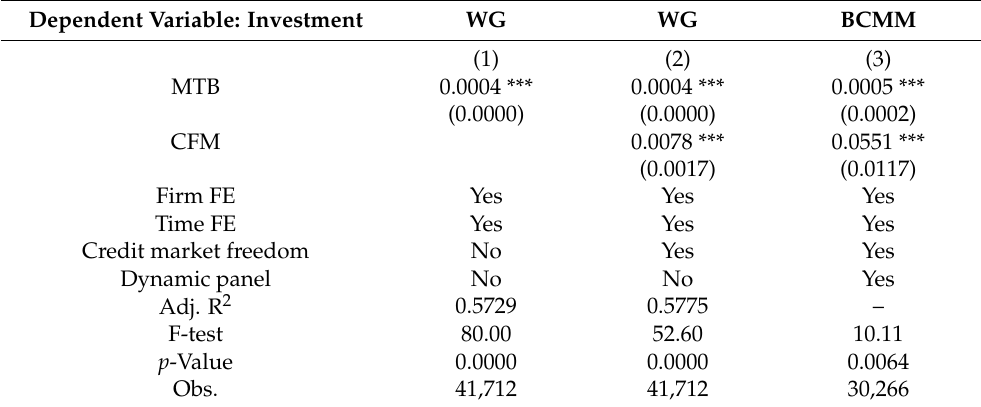
Table 6. Credit Market Freedom and Corporate Investment.